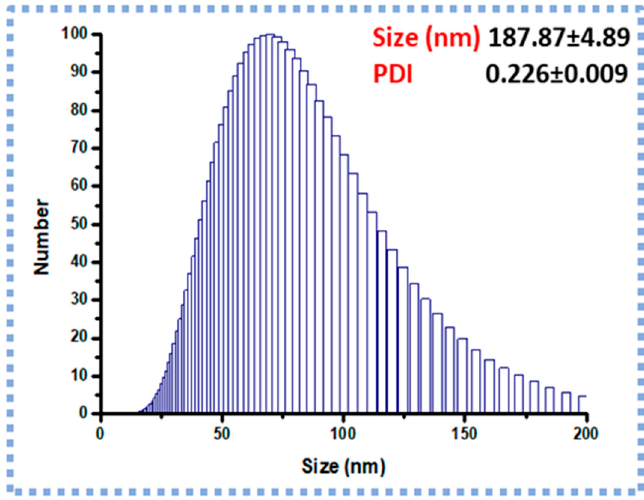
Figure 3. Particle size and size distribution of optimized nanoparticles (NPs) ( n = 3).